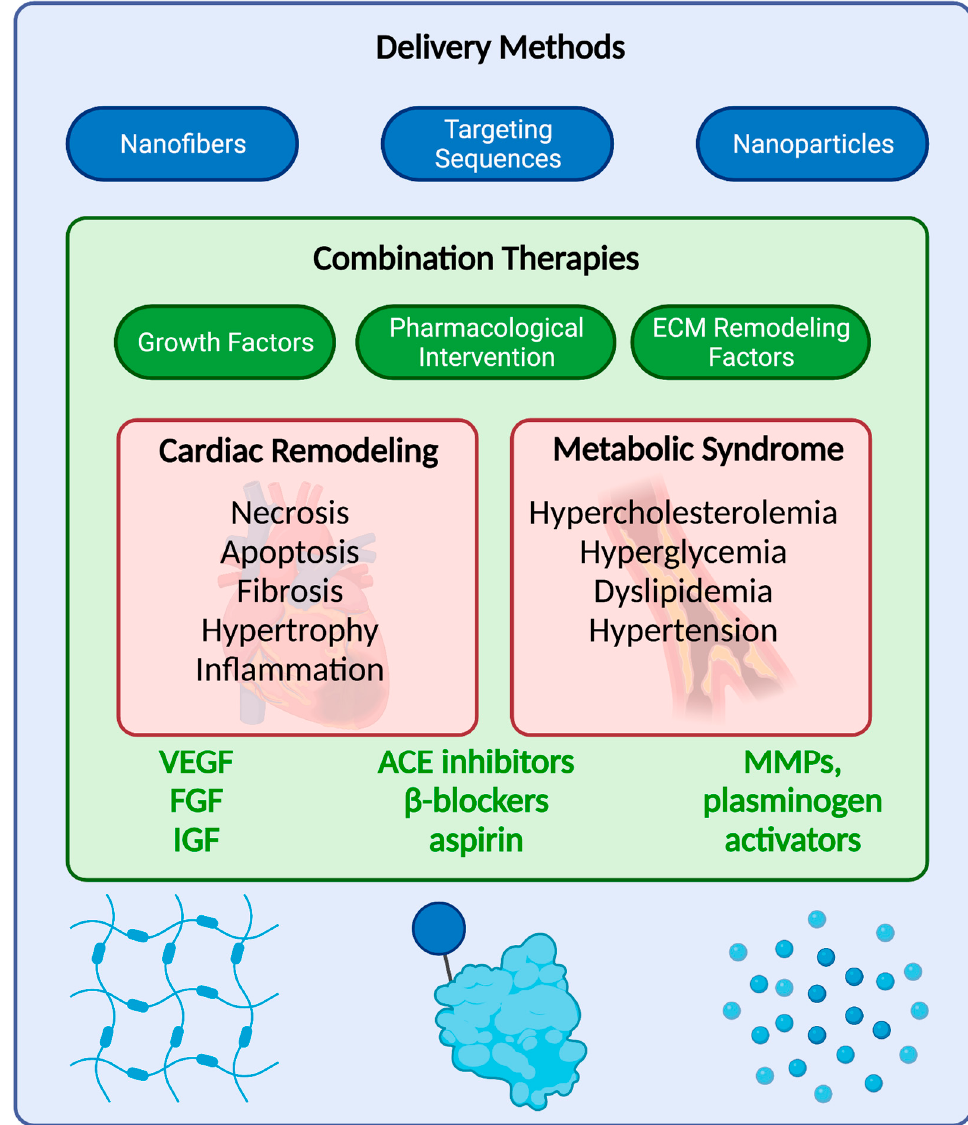
Figure 3. Future challenges and prospects in therapeutic angiogenesis. Cardiac remodeling is char ‐ acterized by widespread maladaptive changes that adversely affect the structure and function